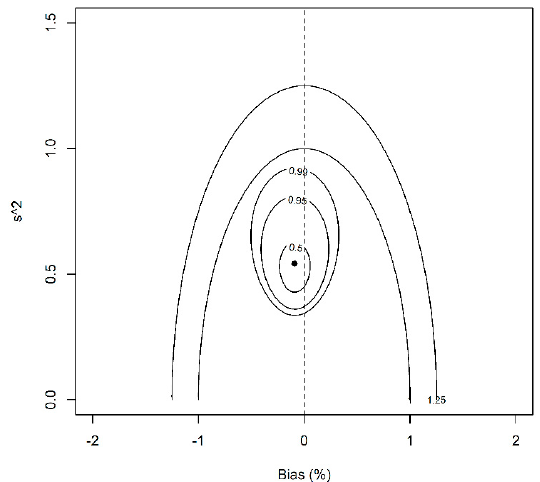
Figure 1. Bayesian posterior distribution of the mean and standard deviation of bevacizumab’s nominal concentration. The overall uncertainty calculated was lower than 1%. The black points correspond to the mean value and precision obtained from reproducibility study.